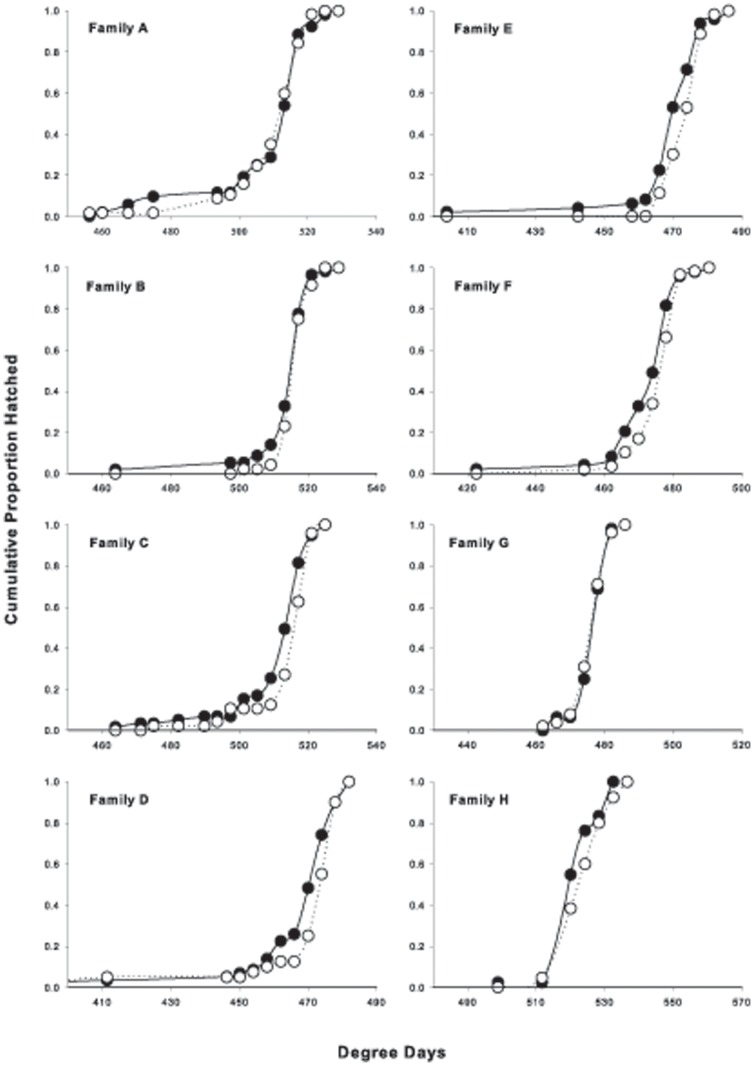
The time of hatch (degree days) of full-sibling transgenic and non-transgenic Atlantic salmon (Salmo salar) from eight families.Transgenic and non-transgenic values are represented by black and white circles, respectively. These data are represented by cumulative proportions of approximately 100 individuals per family.